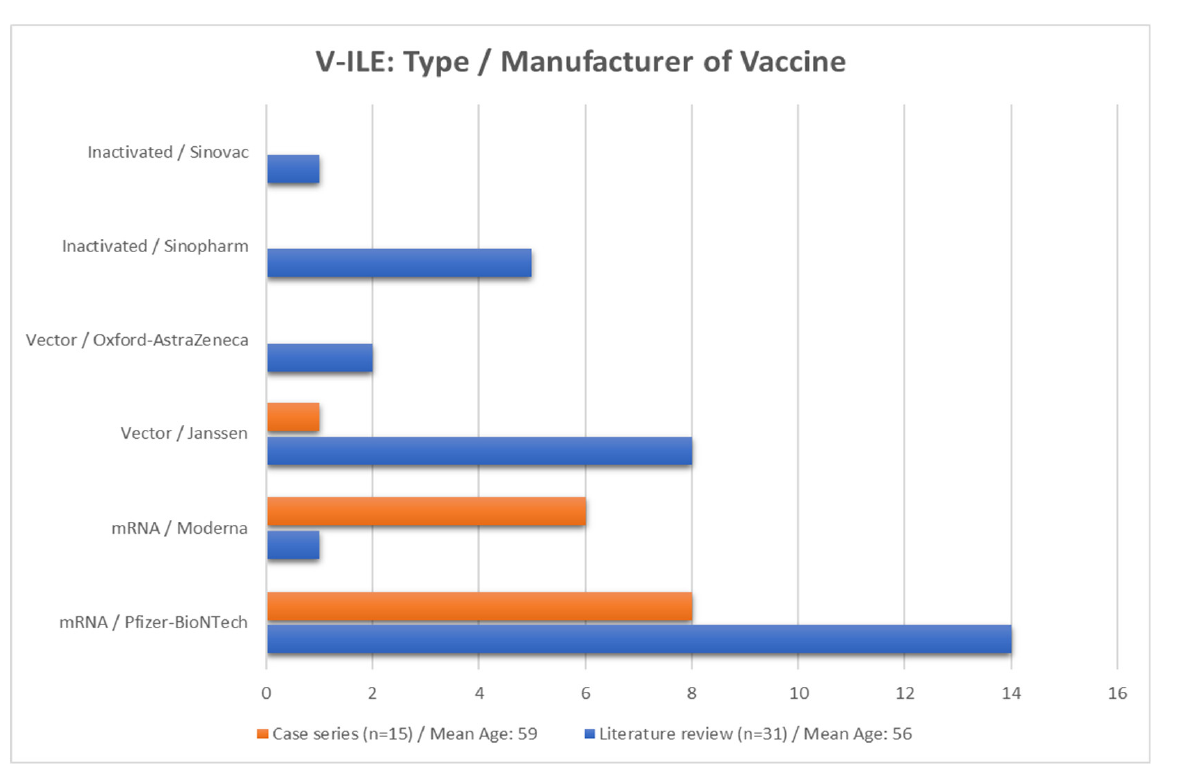
Figure 14. Types and manufacturers of the COVID-19 vaccines administered in the cases from the case series and review of the literature. n = number of cases.